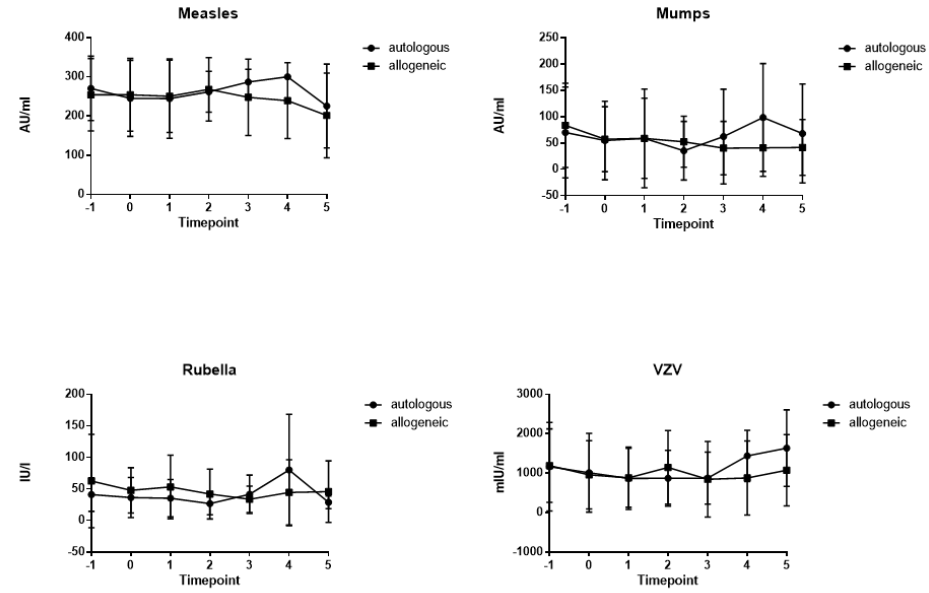
Figure 1. Time course of mean antibody titers for measles, mumps, rubella and varicella from time points T − 1 to T + 5 for allogeneic (squares) and autologous (circles) patients (lines depict standard deviations). Time points: on admission (7 days before HSCT; T − 1), on the day of HSCT (T0), during aplasia (absolute neutrophil count < 0.5 G/L; T + 1), at engraftment (T + 2, neutrophil count > 0.5 G/L), 1 month after HSCT (T + 3), 3 to 6 months after HSCT (T + 4), and 6 to 12 months after HSCT (T + 5).